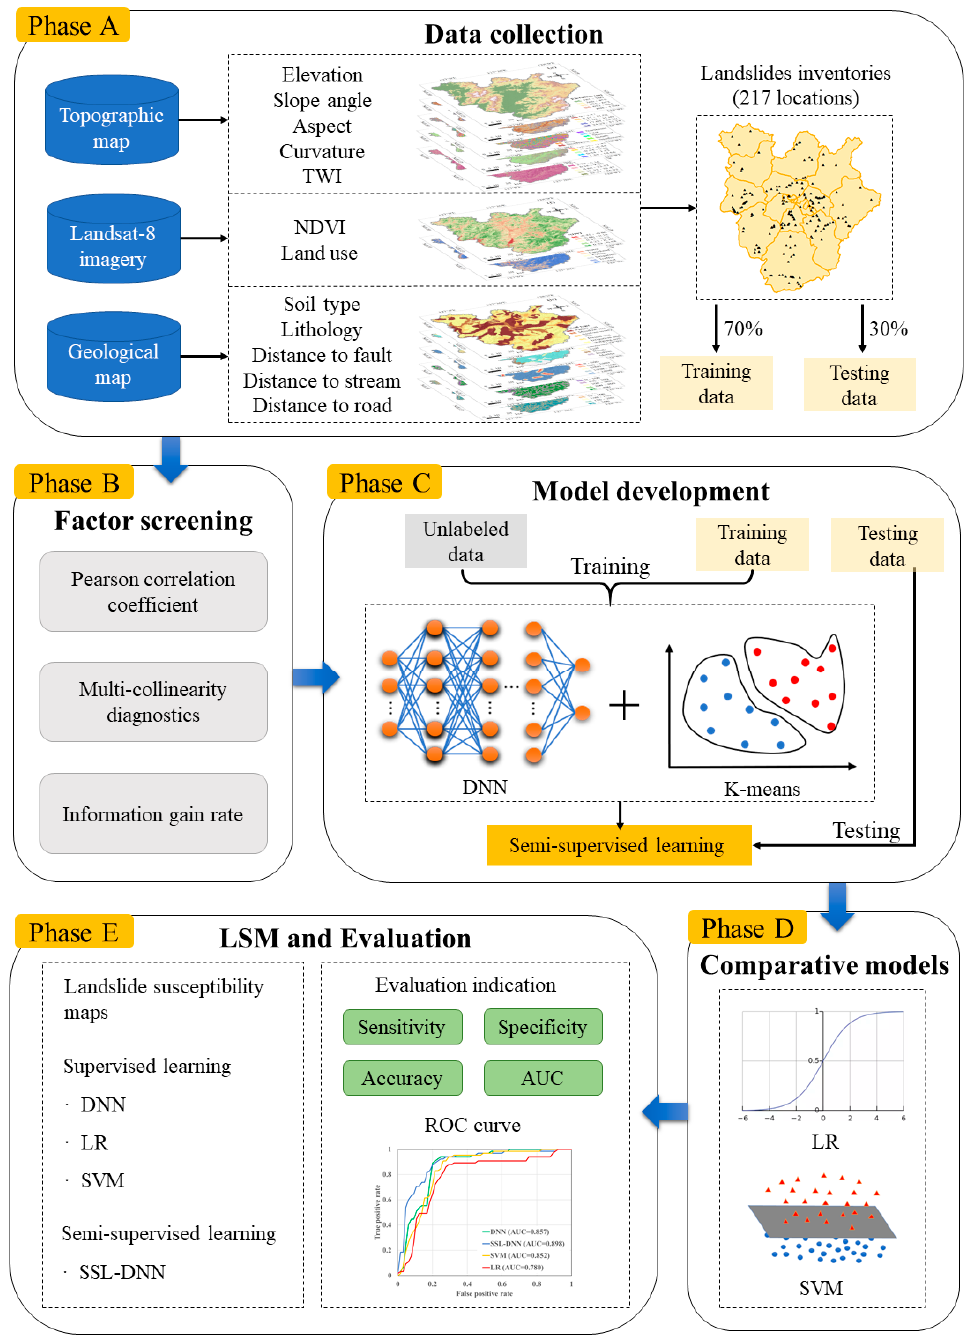
Figure 3. The flowchart of this study.